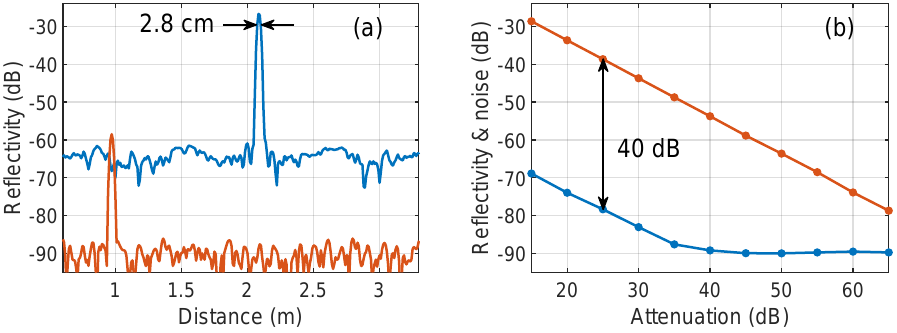
Figure 6. ( a ) System measurements limited by dynamic range (attenuated PC-air reflection, red) and sensitivity, (APC-air reflection, blue); and ( b ) peak (orange) and rms noise floor (blue) levels for progressively attenuated PC-air